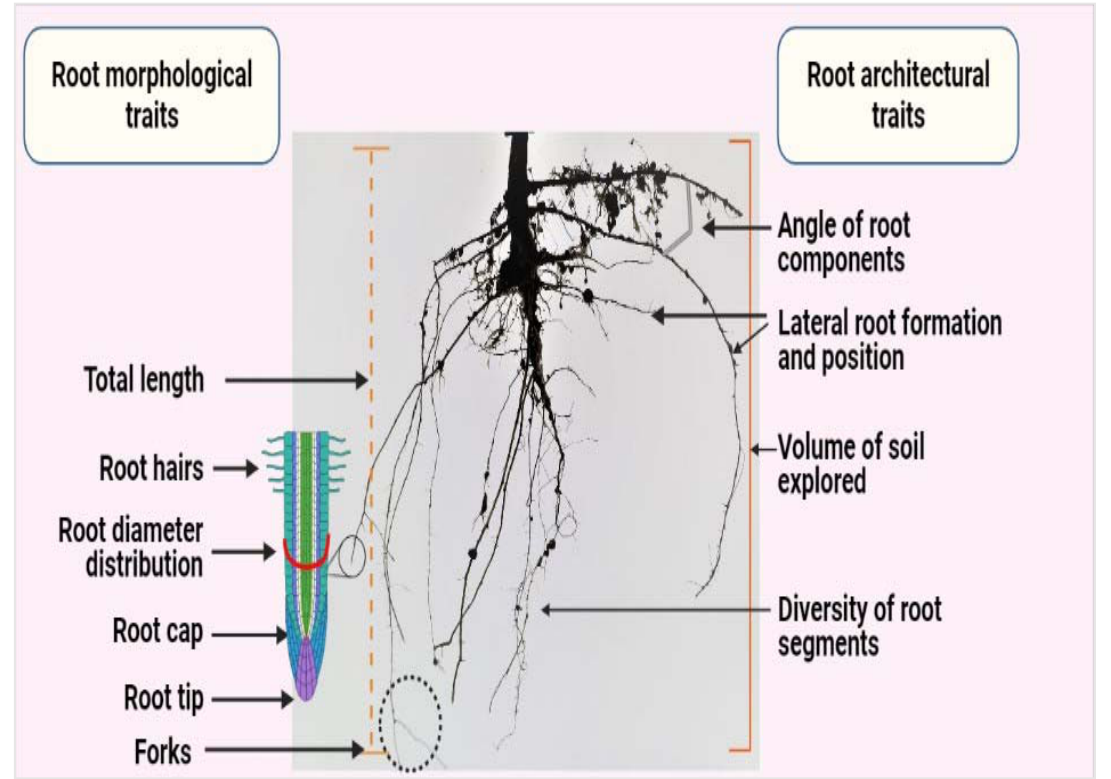
Figure 1. Depiction of morphological and architectural traits of the root system. Currently, various studies focus on the assessment of changes that are due to Si application in the rooting region. Most of these variations are related to either morphological (length, diameter, cap, or hairs) or architectural (root formation and angle of development) traits. Created with BioRender.com.